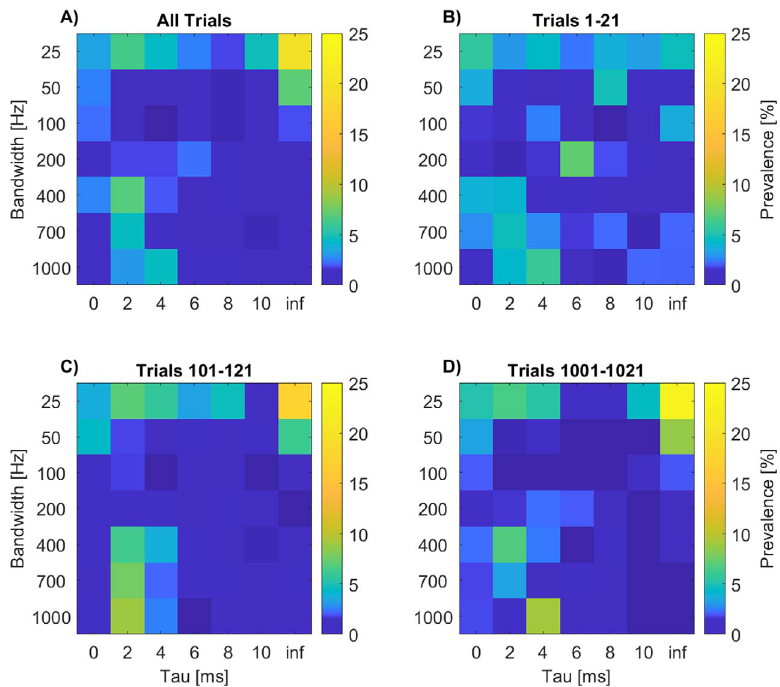
Figure 8. Prevalence of the stimuli selected by the model-based steering as percentages. Once over all trials (A) and, additionally, in certain parts of the experiment (B – D). The data shown are averaged over 100 experiment runs, each of which consisted of 1470